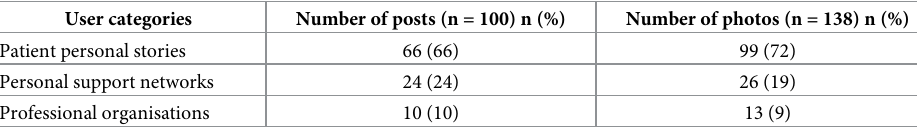
Table 2. Frequency of posts and photos in each user category.